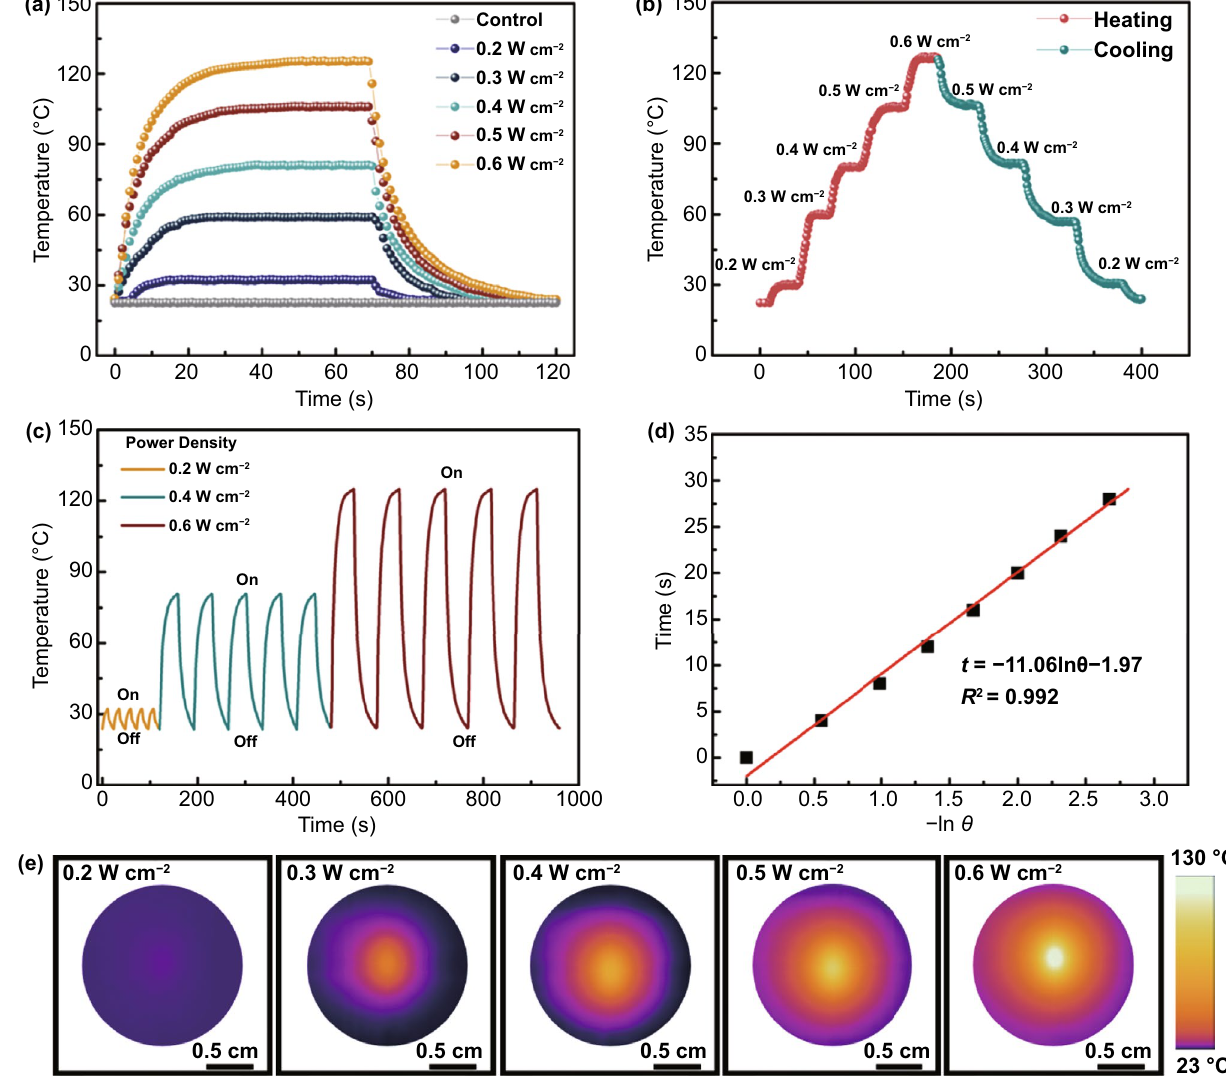
Fig. 6 a Photothermal heating and cooling curves of the PDMS@Ti 3 C 2 T x /CNTs/Co film at different NIR laser power densities. b Tailored surface temperatures of PDMS@Ti 3 C 2 T x /CNTs/Co coating under gradually changing power density. c Heating curves of the PDMS@Ti 3 C 2 T x / CNTs/Co coating for five laser on/off cycles at different NIR laser power densities. d A linear fitting correlation between time ( t ) and -ln θ obtained from the cooling period. e Infrared thermographic photographs of the PDMS@Ti 3 C 2 T x /CNTs/Co coating under power densities rise from 0.2 to 0.6 W cm